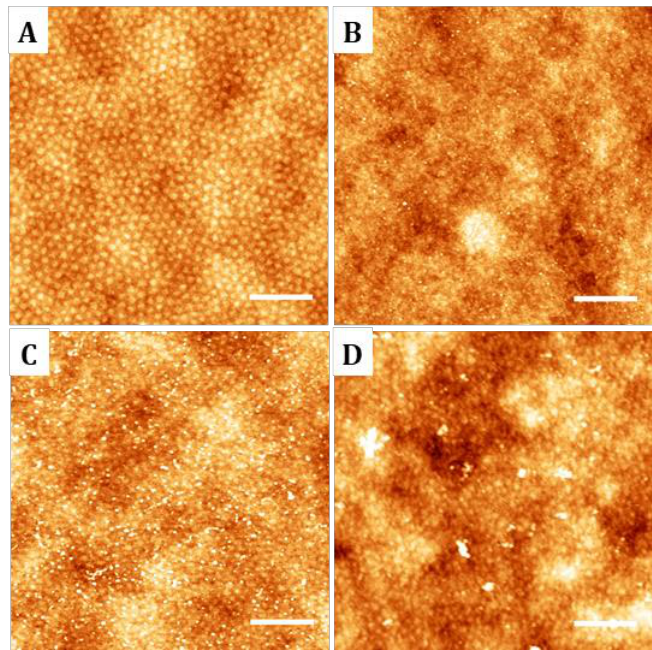
Figure 3. AFM images of the topography of thin films of PS-b-PMMA 123-35 diblock copolymer after hydrolysis reaction in sodium hydroxide 2 M at 40 °C during ( A ) 0 h, ( B ) 0.5 h, ( C ) 1 h, and ( D ) 5 h. Root mean square (RMS) roughness increases from 0.5 nm (0 h) to 0. 8 nm (5 h). Scale bar 400 nm; Z-scale: 5 nm.